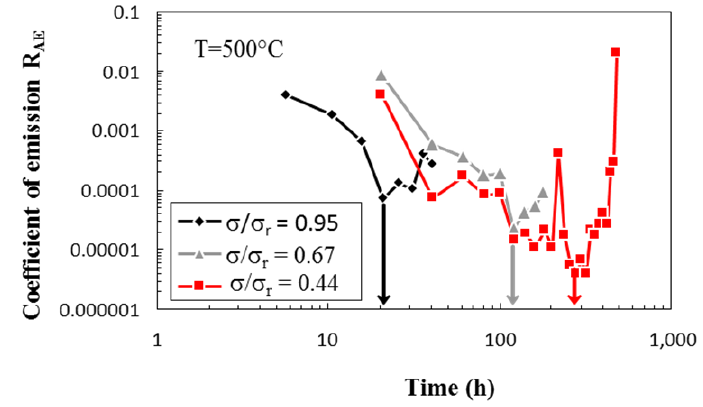
Figure 8. Evolution of the R AE coefficient during the static load hold on SiC f /[Si-B-C] composites.